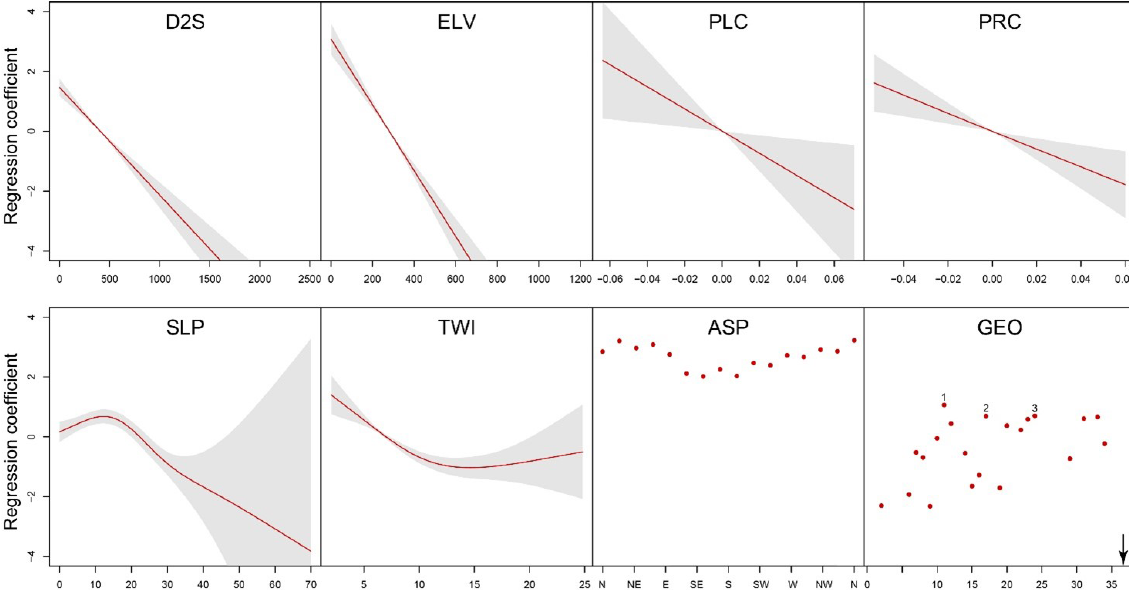
Figure 5. Covariate effects estimated for TSs. Notably, the regression coefficients estimated for outcropping lithologies also host strong negative values. For pure visualisation purposes, we have focused on representing a coefficient range in which the positive classes would still appear to be visible. Also, to avoid clustering the text, we have described in the text only the three strongest and positive contributors, labelled 1, 2, and 3 in the